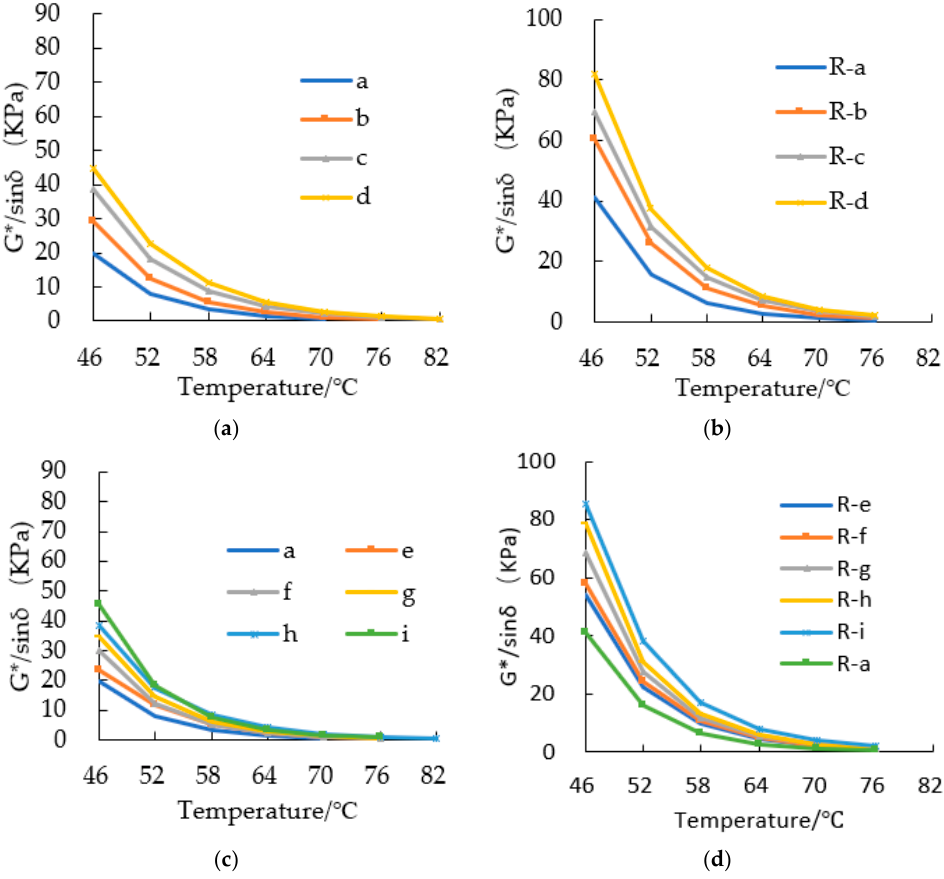
Figure 10. G*/sin ( δ ) of modified asphalt binders. ( a ) G*/sin ( δ ) of unaged SBS asphalt binders; ( b ) G*/sin ( δ ) of aged SBS asphalt binders; ( c ) G*/sin ( δ ) of unaged CRM asphalt binders; ( d ) G*/sin ( δ ) of aged CRM asphalt binders.